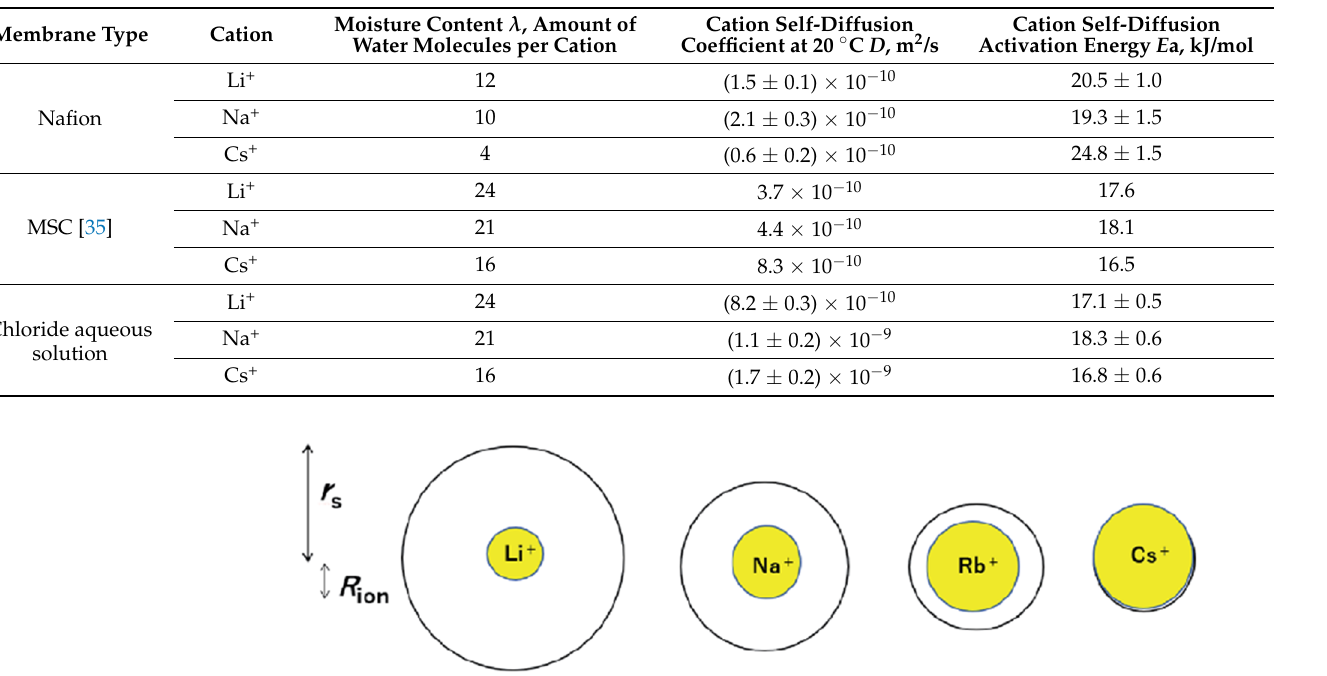
Table 7. Moisture content λ , amount of water molecules per cation, self-diffusion coefficients D at 20 ◦ C, self-diffusion activation energies E a of Li + , Na + , and Cs + cations in the Nafion membrane, MSC membrane at RH = 98%, and chloride aqueous solutions [35,60].